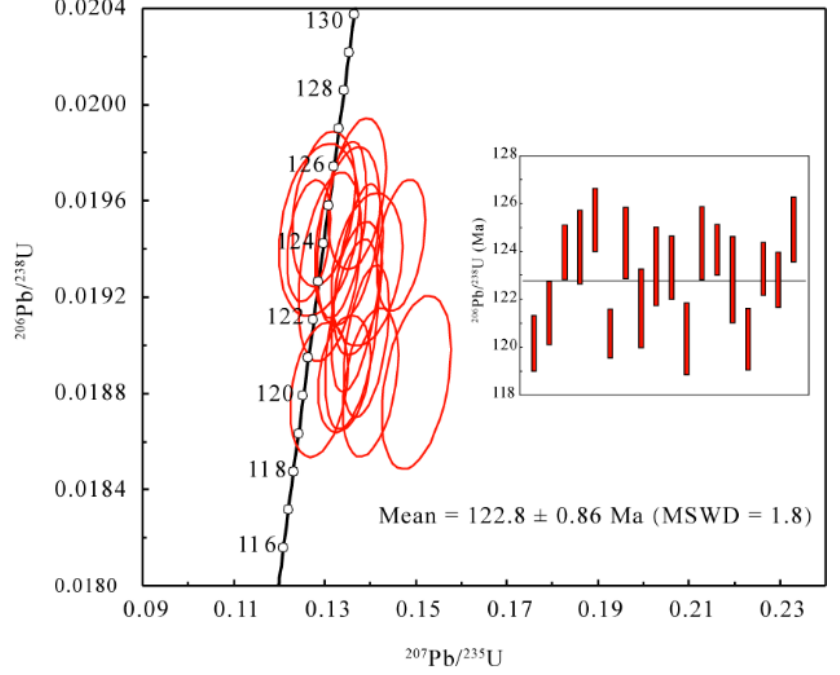
Figure 5. LA–ICP ‐ MS zircon U–Pb age for the Saozhouhe andesitic porphyrite.